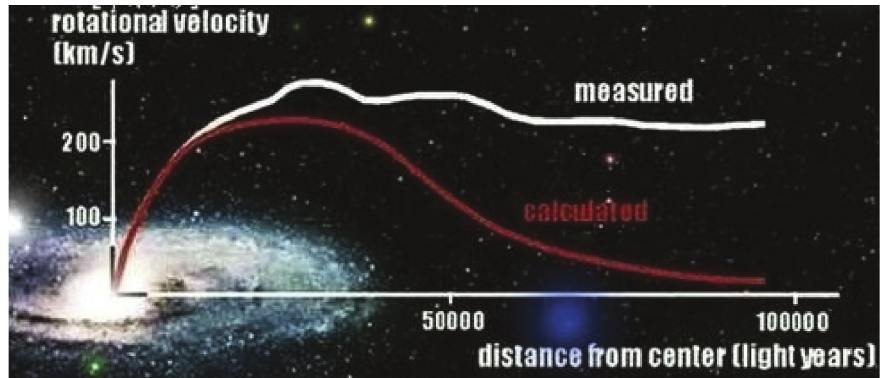
Figure 5: The schematic diagram of the speed distribution of matter in the Milky